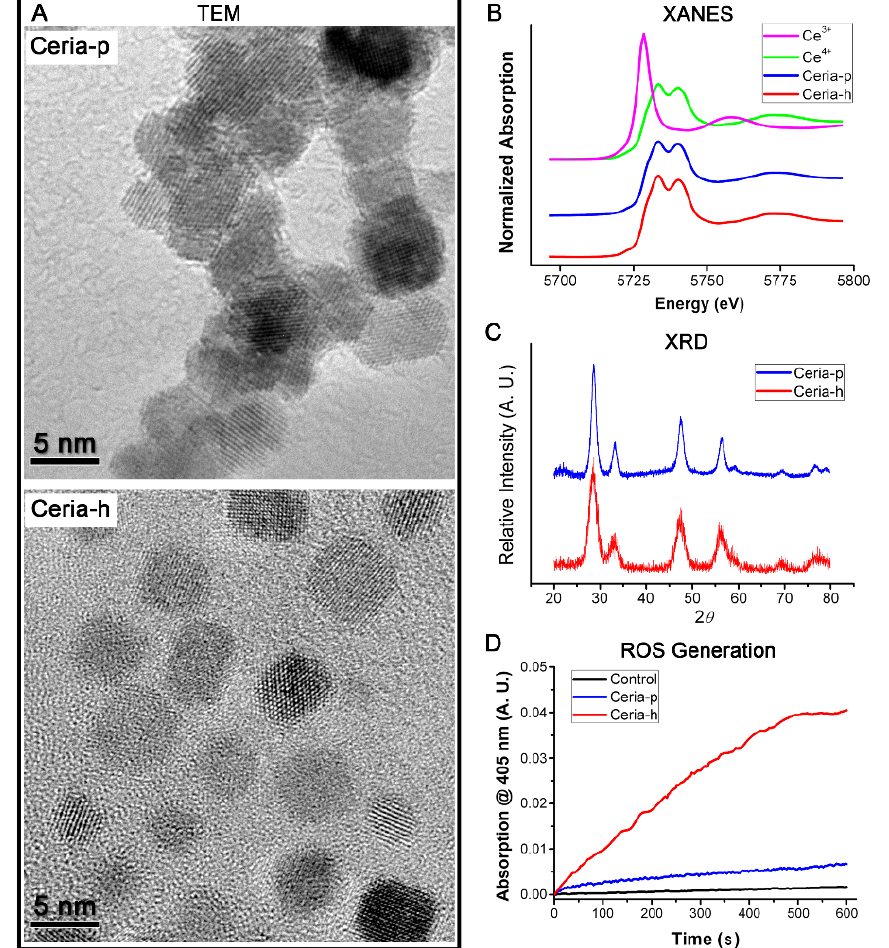
Figure 1. The physicochemical characteristics of Ceria-p (synthesized via precipitation) and Ceria-h (synthesized via the hydrothermal method). ( A ) transmission electron microscopy (TEM) images of Ceria-p and Ceria-h; ( B ) the X-ray absorption near-edge structure (XANES) spectra of Ceria-p and Ceria-h; ( C ) the X-ray diffraction (XRD) patterns of Ceria-p and Ceria-h; and ( D ) the generation of reactive oxygen species (ROS) catalyzed by Ceria-p and Ceria-h in the presence of hydrogen peroxide; and the form of 2,2'-azinobis-(3-ethylbenzthiazoline-6-sulfonic acid) cation radical (ABTS +# ) was photometrically determined at 405